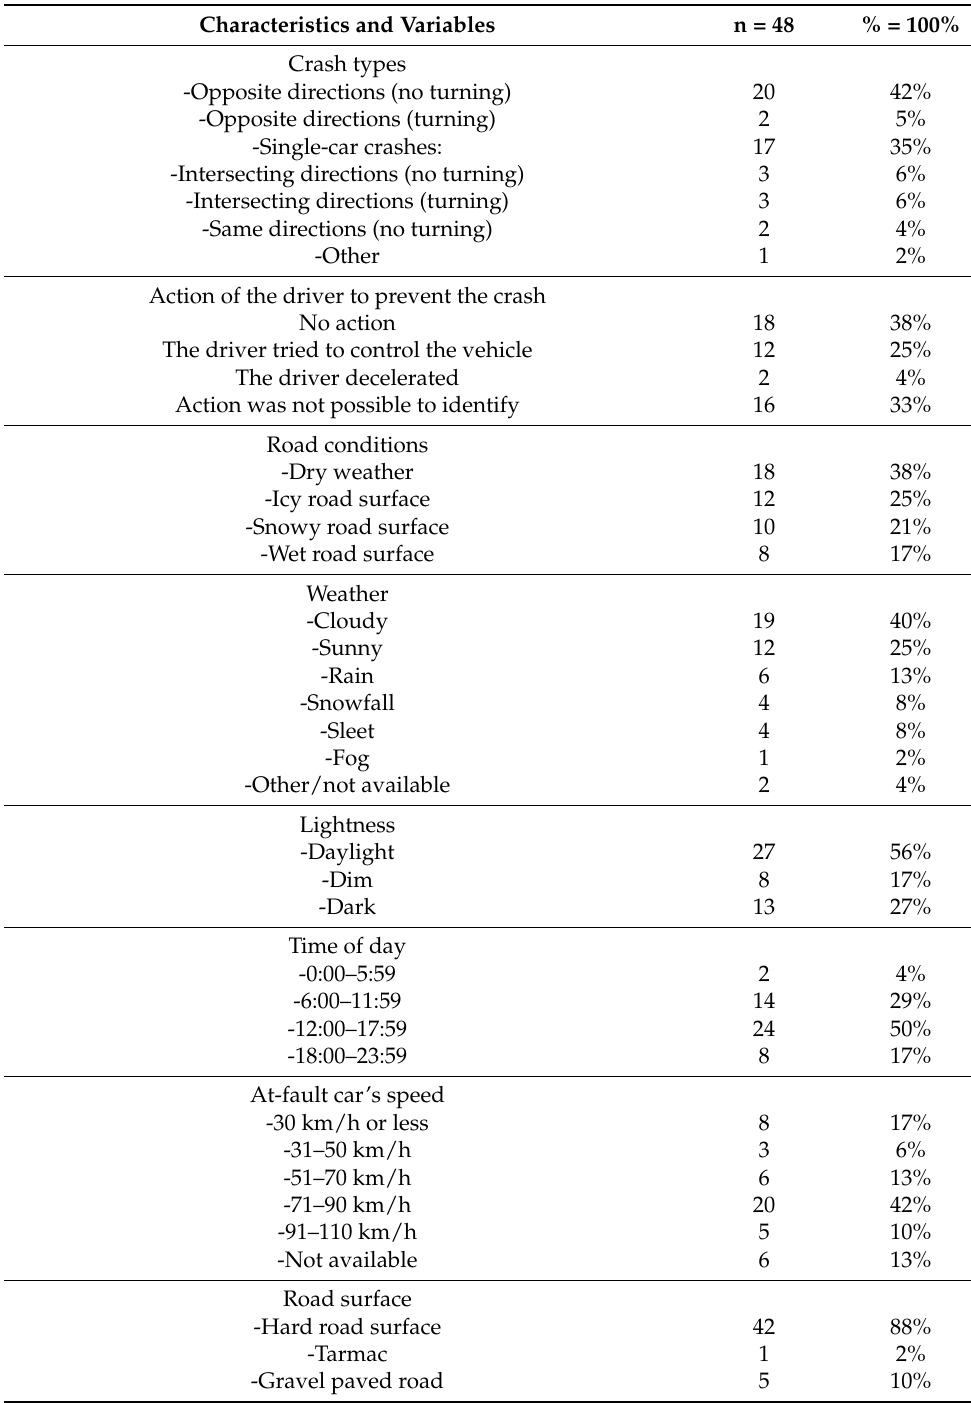
Table A1. Circumstances and other crash-related factors of the 48 studied